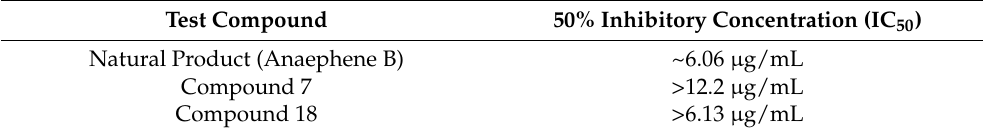
Table 2. IC 50 Values for Anaephene B and Analogs Against L. tarentolae .